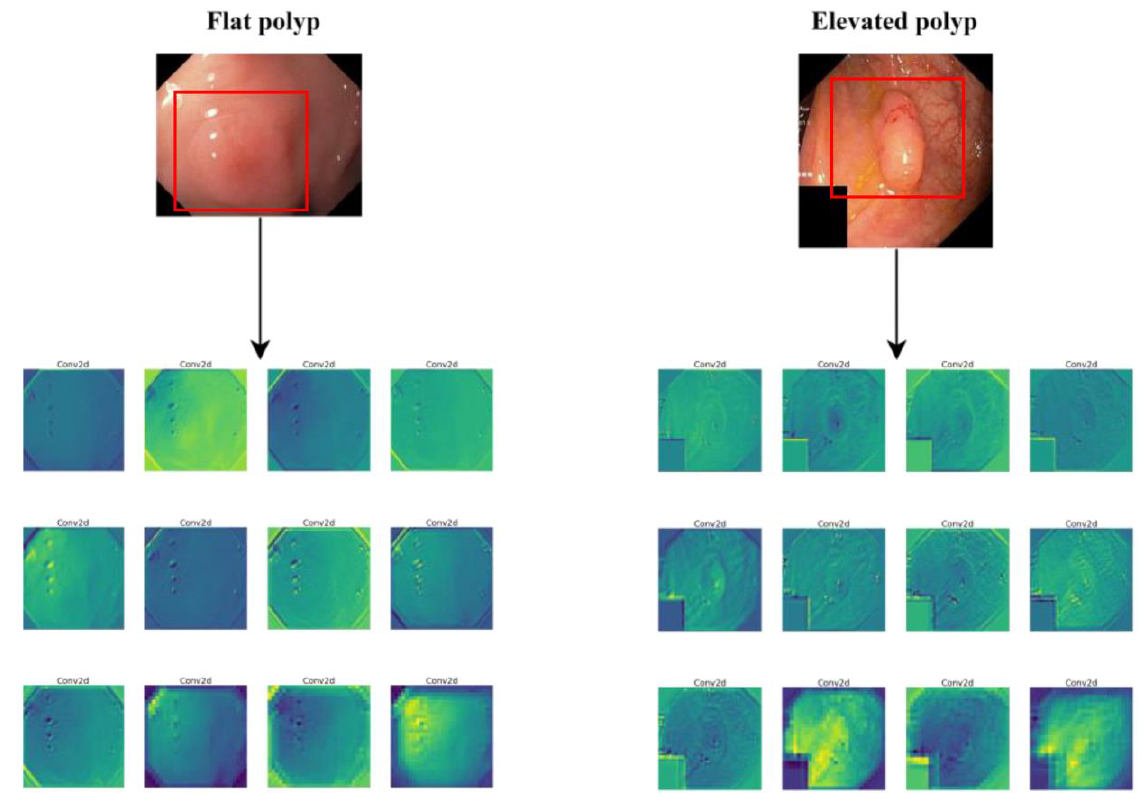
Figure 4. A comparison of the feature map extracted from a sample with a flat polyp (left) versus the features extract from an image with an elevated polyp. Samples were taken from Kvasir-SEG dataset.